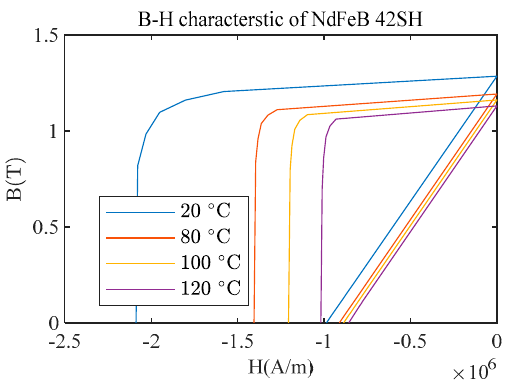
Figure 3. The potential energy of springs; permanent magnet energy density calculated from B-H characteristic is a measure of the maximum theoretical energy density of a magnetic spring.